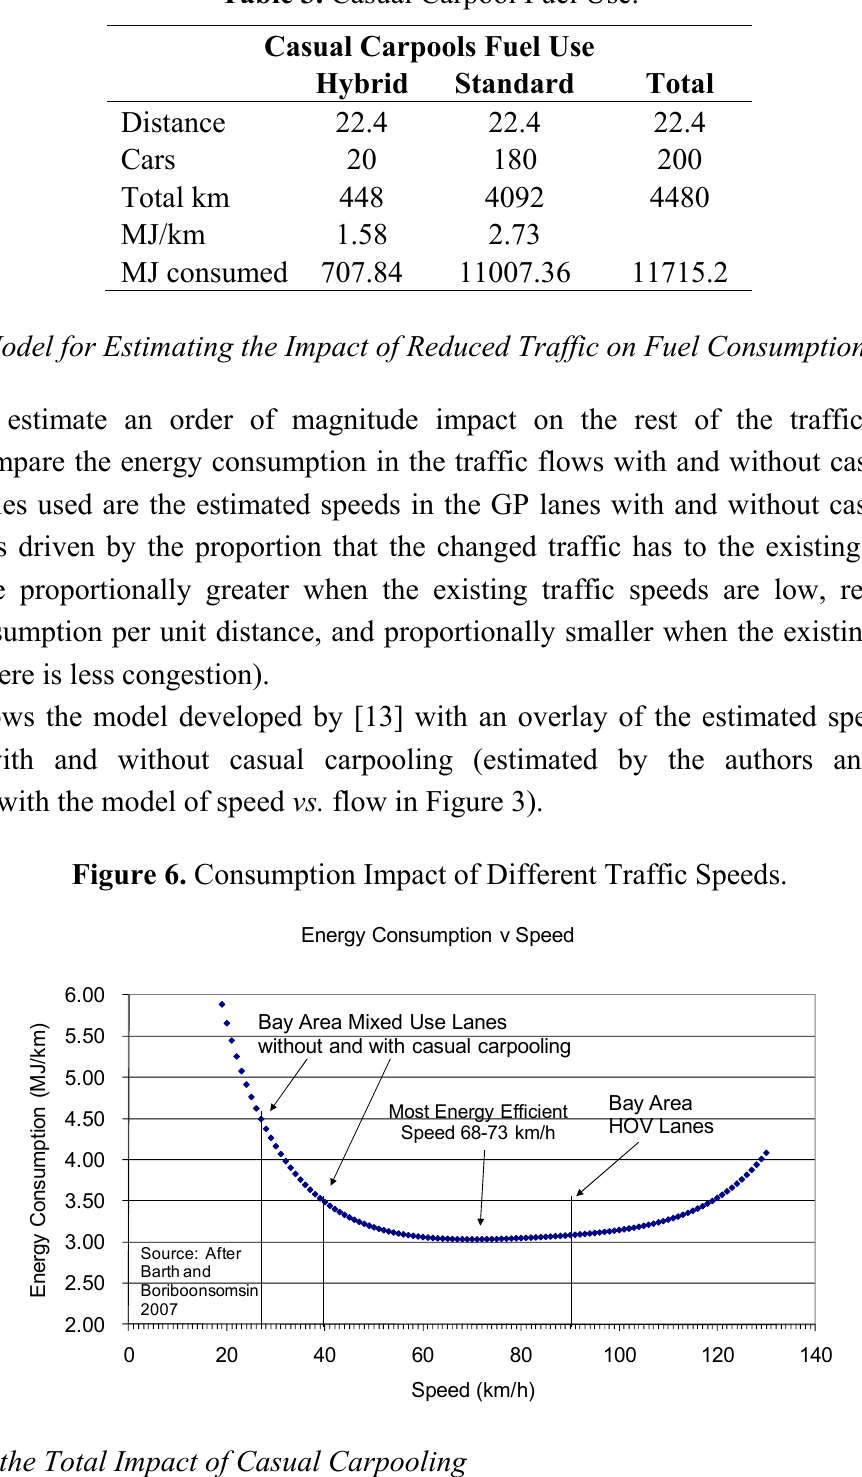
Table 3. Casual Carpool Fuel Use.